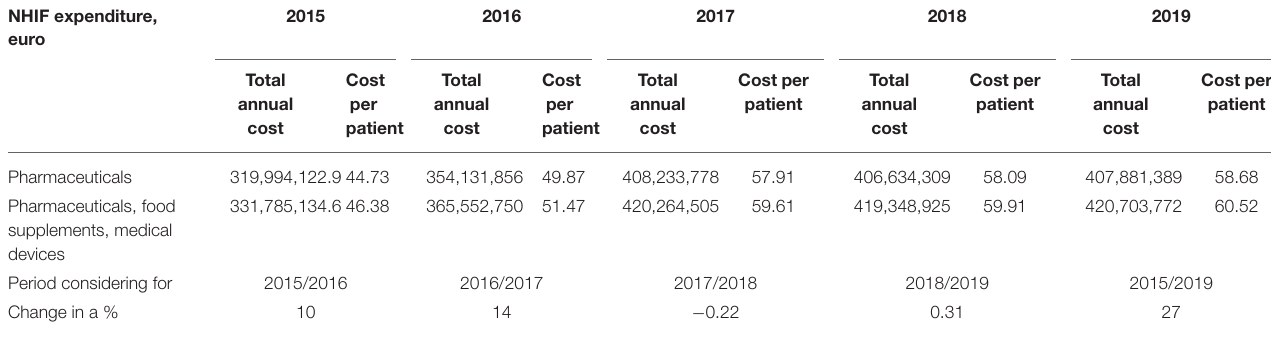
TABLE 3 | NHIF expenditures during